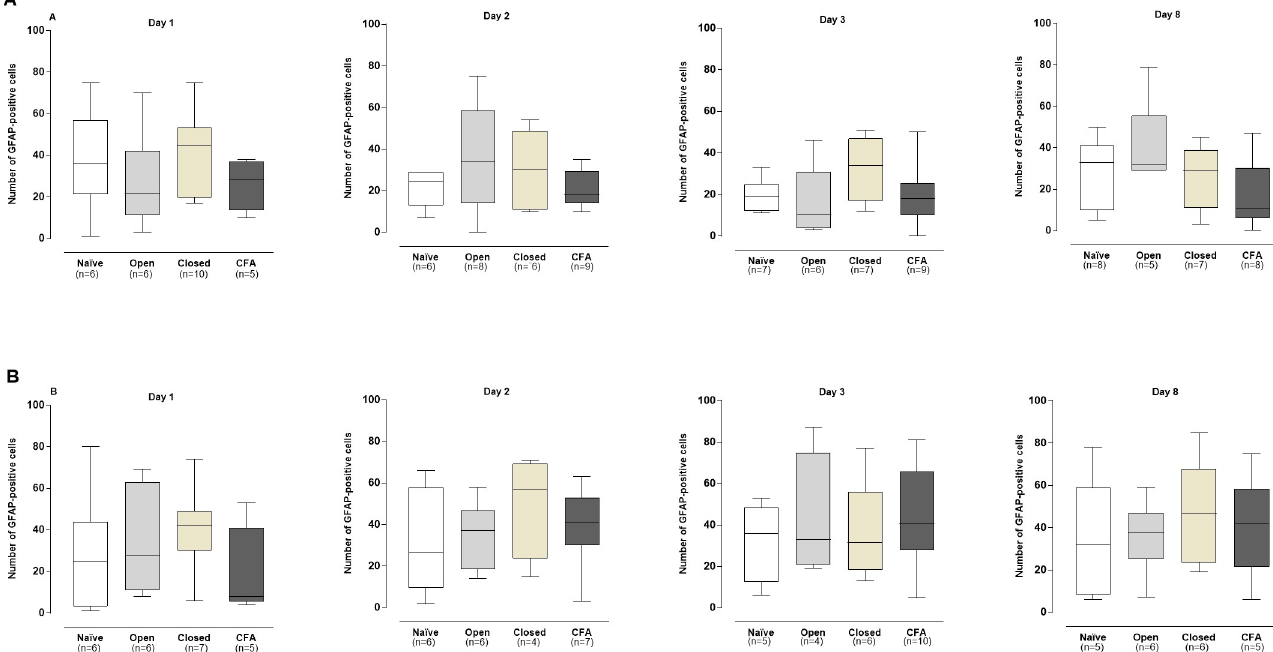
Fig 9. GFAP-immunopositive astrocytes in the ipsilateral (A) and contralateral (B) amygdala in the different experimental groups . The box plots show the median of 4–7 experiments with the upper and lower quartiles. The whiskers indicate the maximal and the minimal values (P > .05; Kruskal-Wallis plus Dunn’s